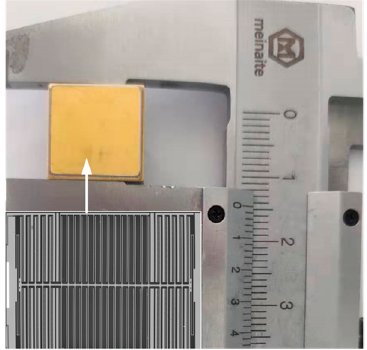
Figure 7. The MEMS electric-field sensor and the internal MEMS-chip microstructure.